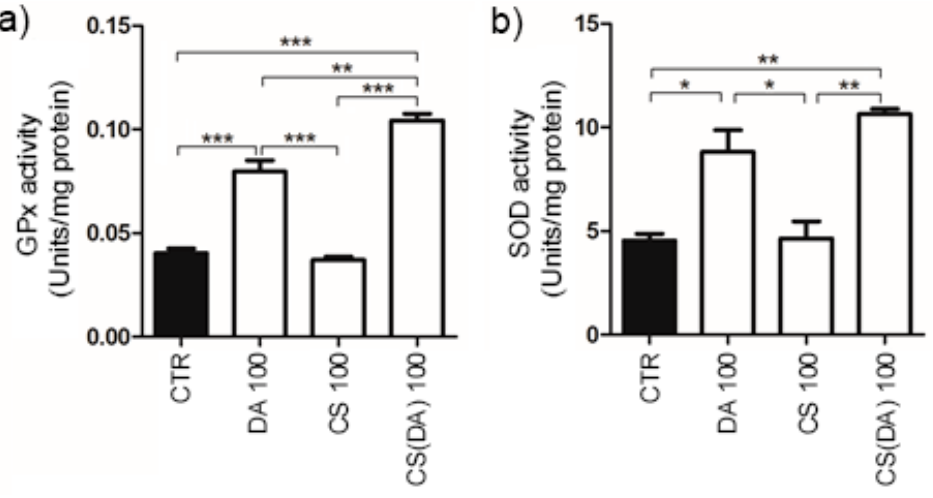
Figure 5. ( a ) GPx and ( b ) SOD antioxidant enzyme activity in control and SH-SY5Y cells treated with 100 µM DA, CS NPs and CS(DA) NPs. Asterisks indicate statistical differences between the selected data series (* p < 0.05; ** p <0.005; *** p < 0.001).